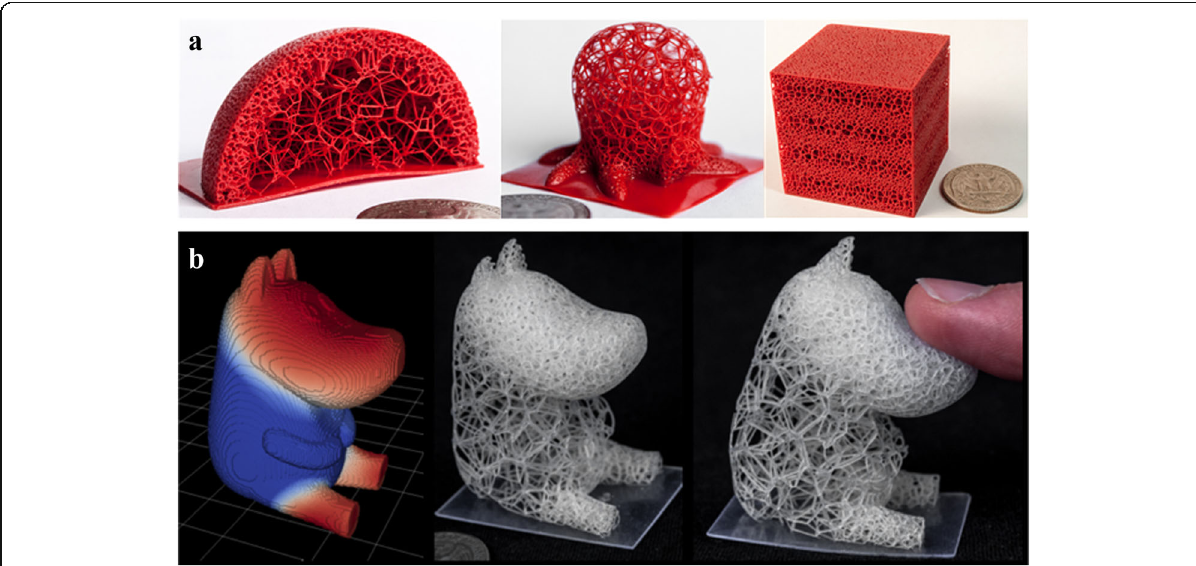
Fig. 6 Voronoi foam design for additive manufacturing: a The design and fabrication results. b Graded material elasticities for load bearing